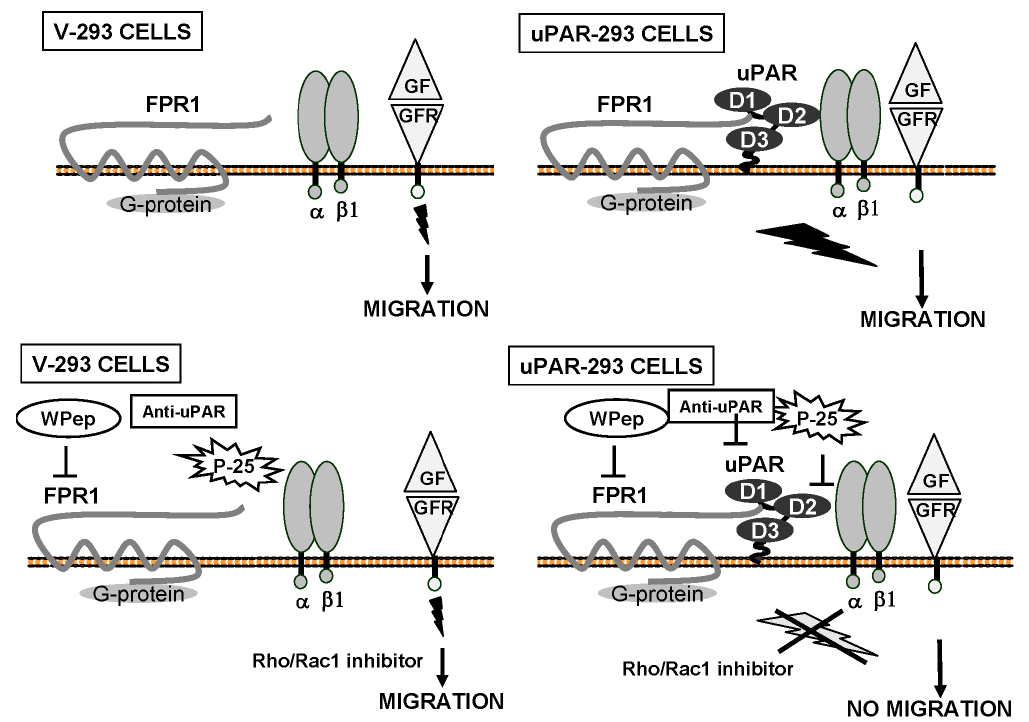
Figure 9. uPAR expression controls cell migration. uPAR-293 and V-293 cells efficiently migrate toward serum growth factors or EGF (GF). However, uPAR, when expressed, recruits and bridges fMLFRs and b 1 integrin at the cell surface, thus driving pro-migratory signaling (upper panels). In fact, anti-uPAR antibodies (anti-uPAR), FPR1 desensitization by the W peptide (W Pep), inhibition of uPAR/ b 1 integrin interaction by P-25 peptide (P-25) or of specific cell signalling mediators block migration of uPAR-293 cells without affecting migration of uPAR-negative V-293 control cells (lower panels).